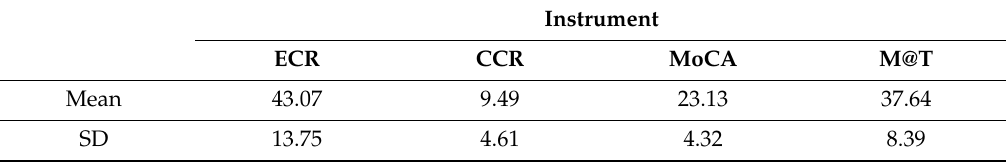
Table 1. Means, standard deviations and standard mean error in the instruments used.